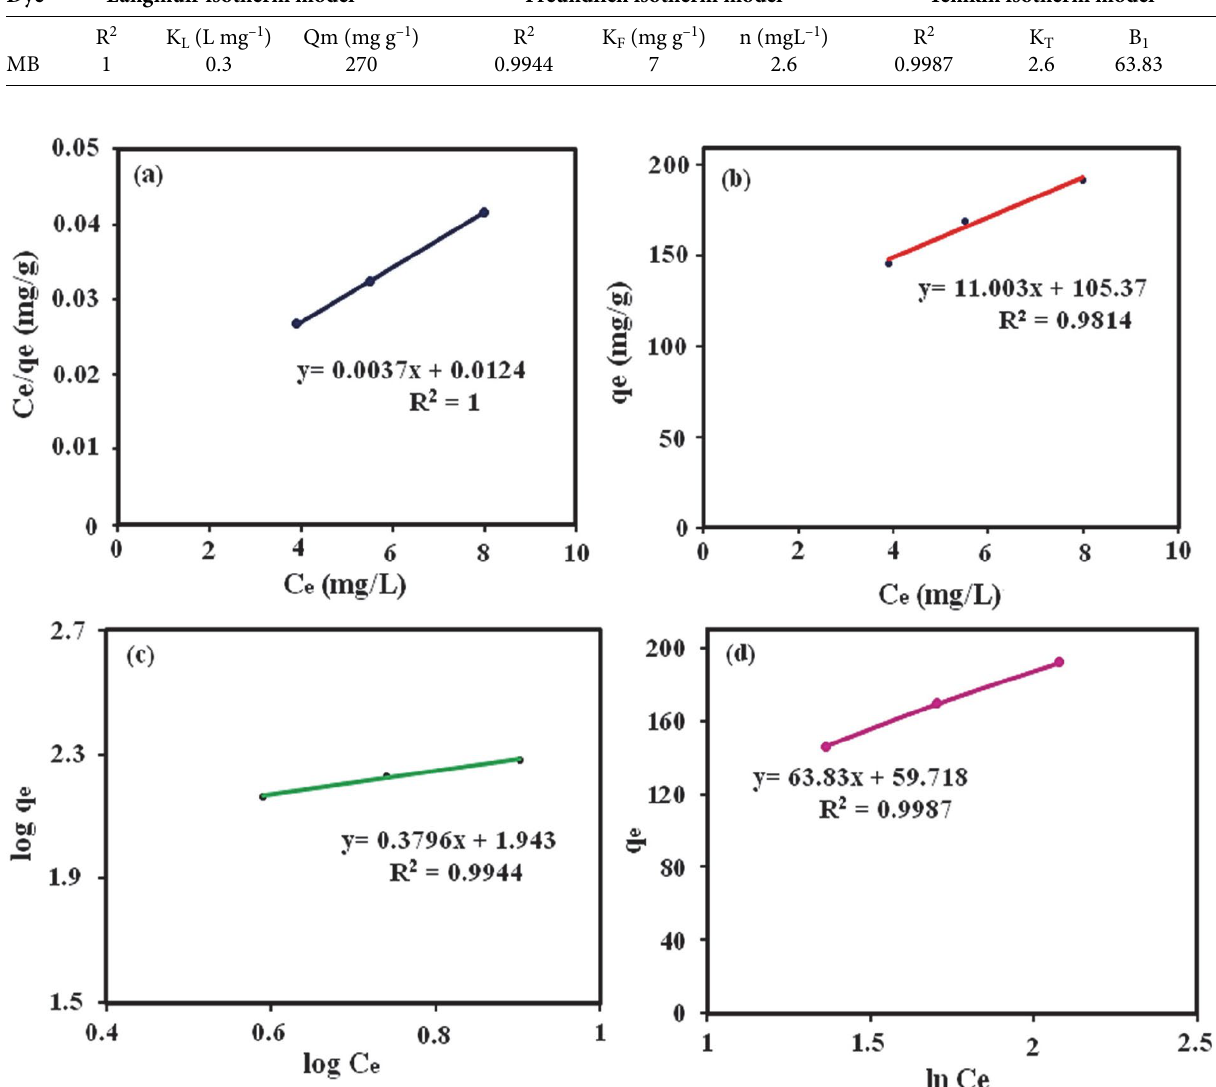
Table 4. Isotherm constants for MB dye adsorption at 150, 175 and 200 mg/L dye concentrations Dye Langmuir isotherm model